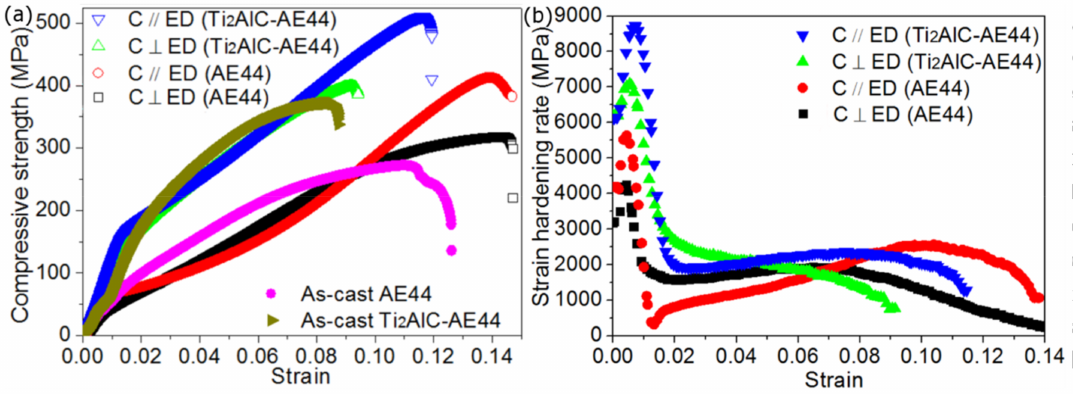
Figure 6. ( a ) Di ff erent room-temperature compressive stress–strain curves of as-cast and extruded specimens, ( b ) d σ / d ε - ε slope relations derived from stress-strain curves of extruded